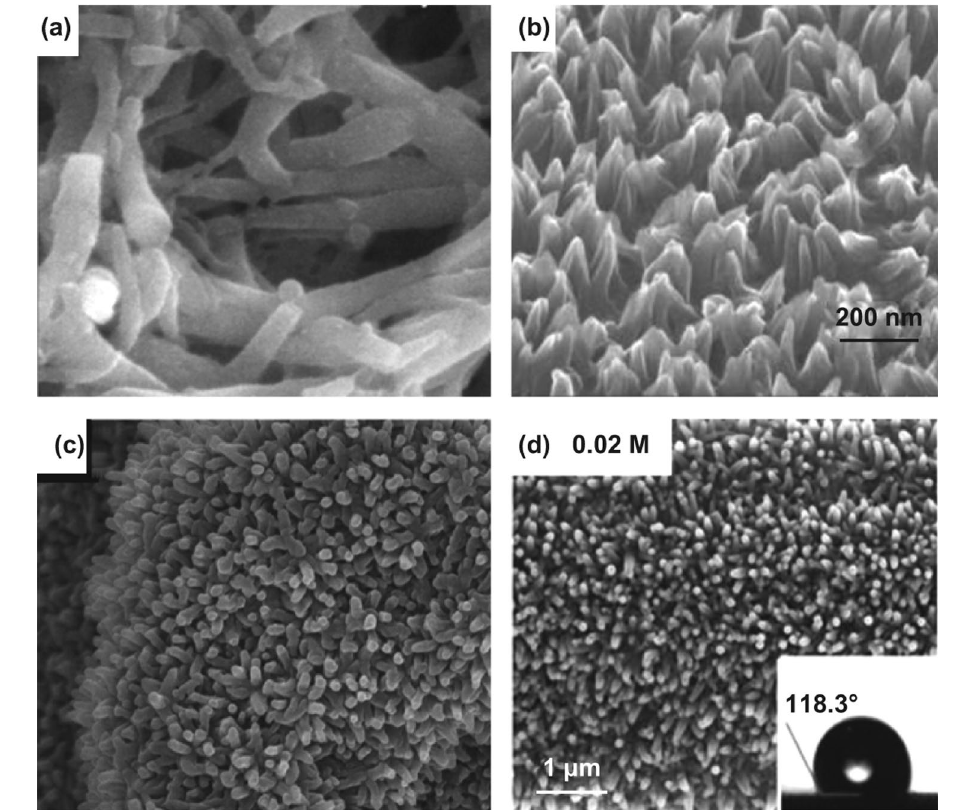
Fig. 13 Electrochemically deposited 1D polymer structures. a PANI nanofibers on carbon cloth; b PANI nanorod arrays on Au plates; c PANI nanorod arrays on carbon nanotube paper; d PPy nanorod arrays on carbon cloth. Adapted from a Ref. [25], b Ref. [153], c Ref. [145], d Ref. [149] with